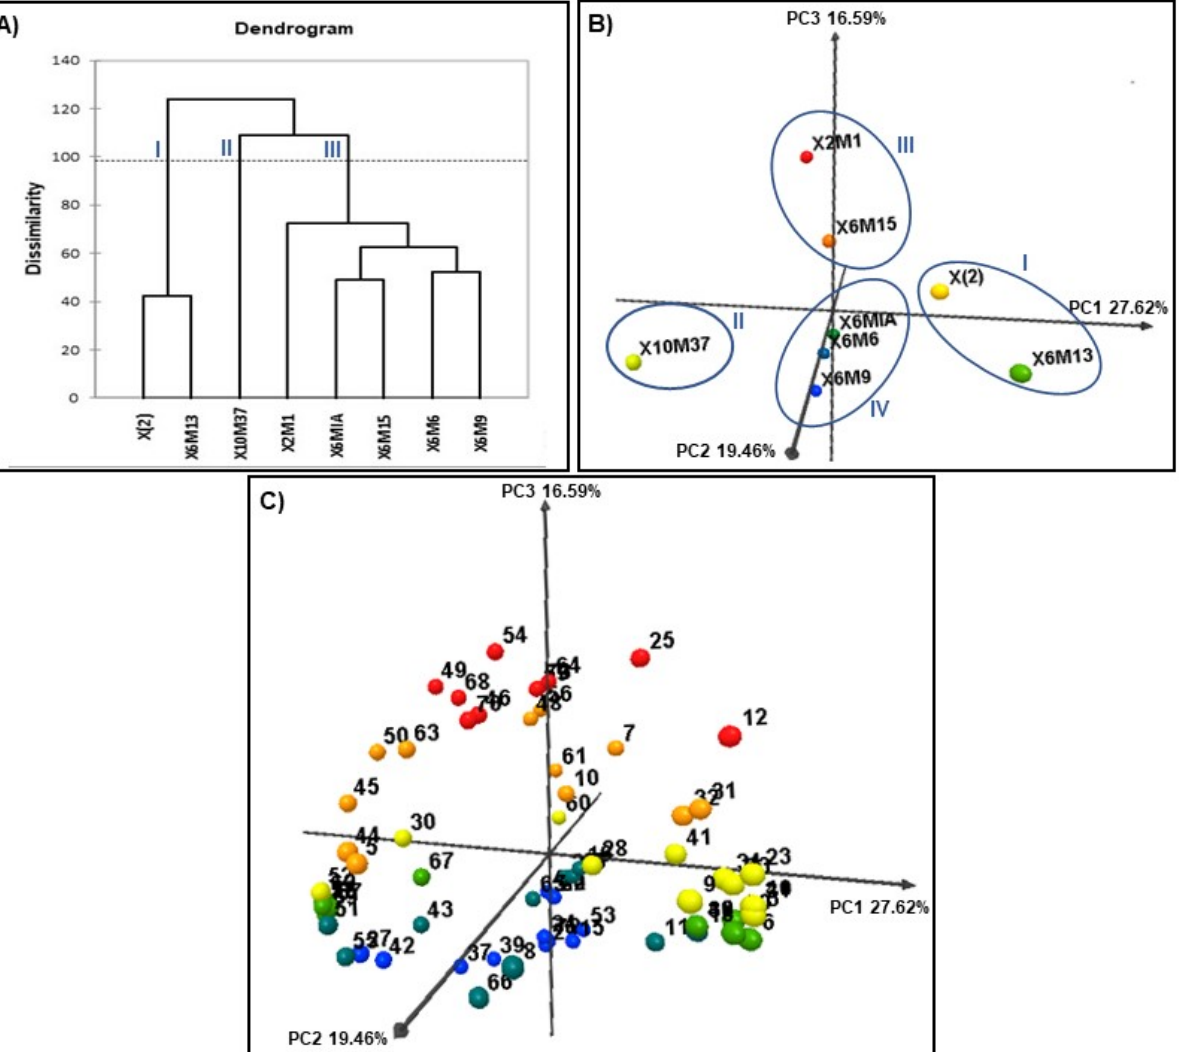
Figure 5. Dendrogram ( A ) obtained from HCA, scores plot ( B ) and loadings plot ( C ) obtained from PCA of the chemical composition data of the L. alba essential oils. Numbers in loadings plot ( C ) represent the identified compounds as described in Table 2.